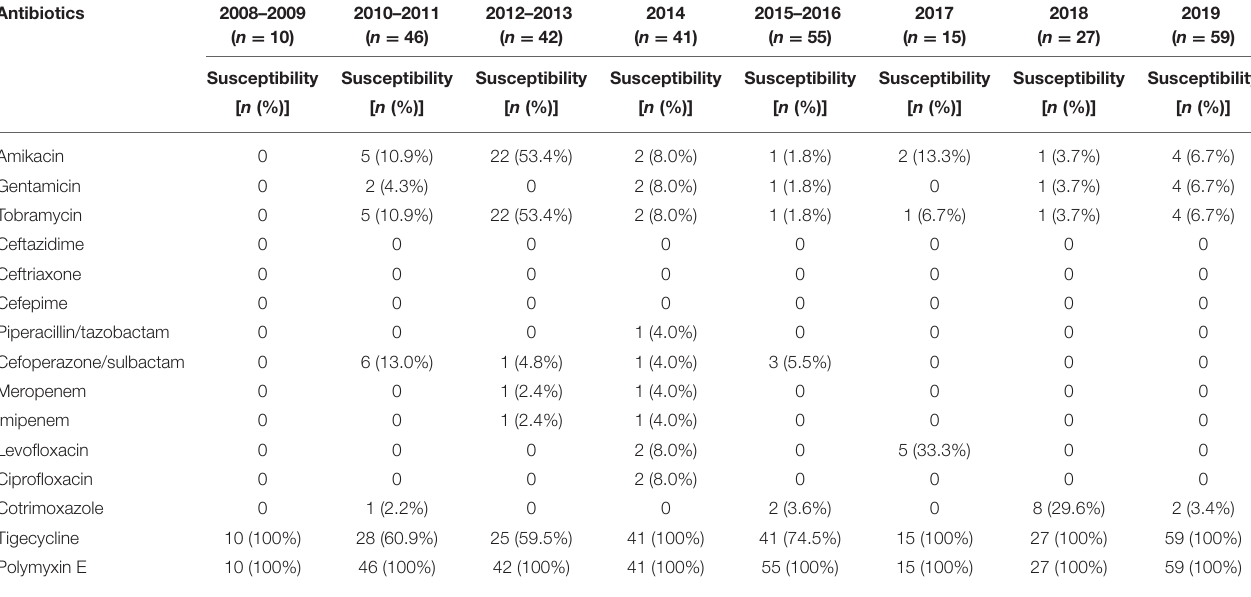
TABLE 3 | The antimicrobial susceptibility testing of A. baumannii isolates to 15 antibiotics over the past 12 years.